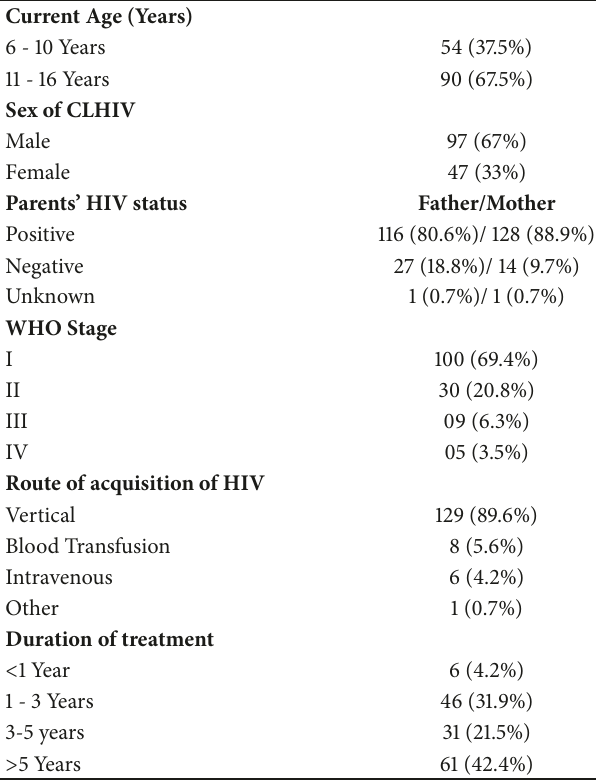
Table 1: Patient